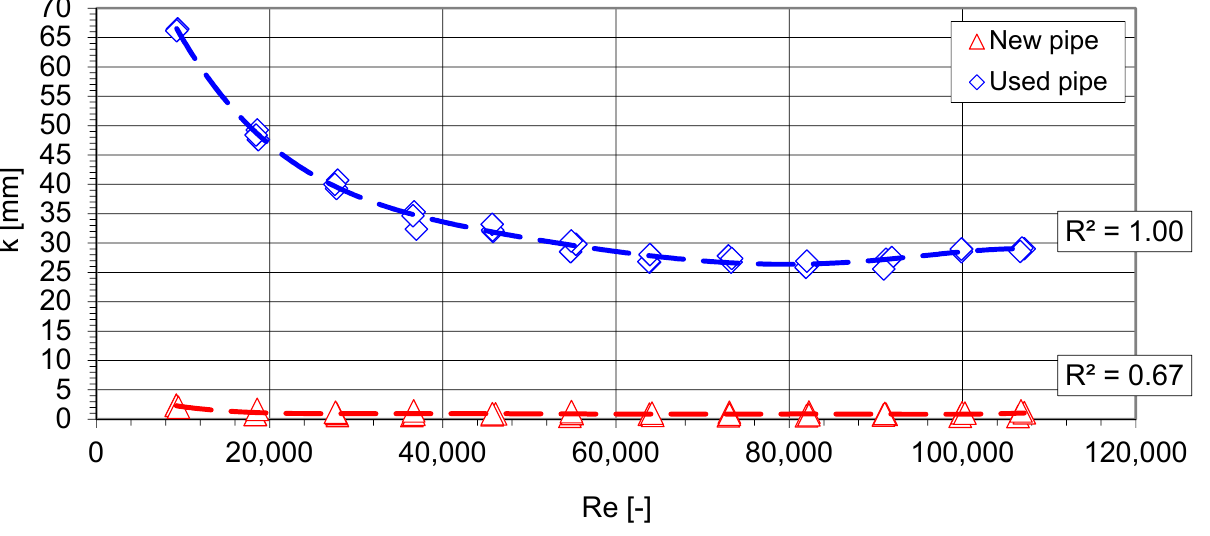
Figure 11. Average values of absolute roughness k of the internal pipeline wall calculated for the cast-iron pipes with the internal diameter d = 150 mm according to Eq. (8) for the new pipe and the pipes after 30-year exploitation. Table 5. Results of calculations of the Student’s t-statistics. The differences of average values are significant with probability p <